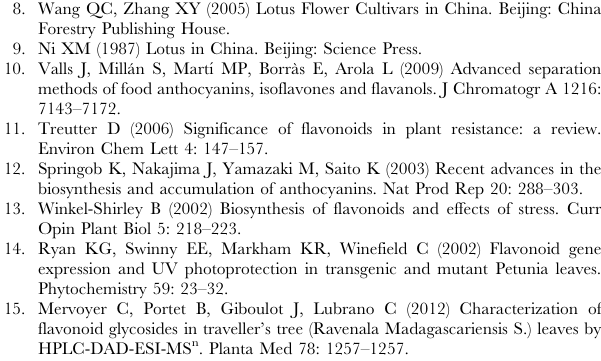
Table S1 Linearity, LOD and LOQ in the determination of three anthocyanins and five non-anthocyanin flavo- noid standards. Table S2 Intra- and inter-day precision for each of the lotus petals flavonoids separated by